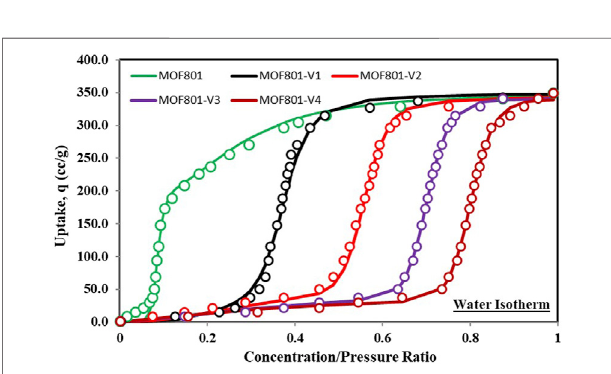
FIGURE 2 | Isotherm of MOF 801 and